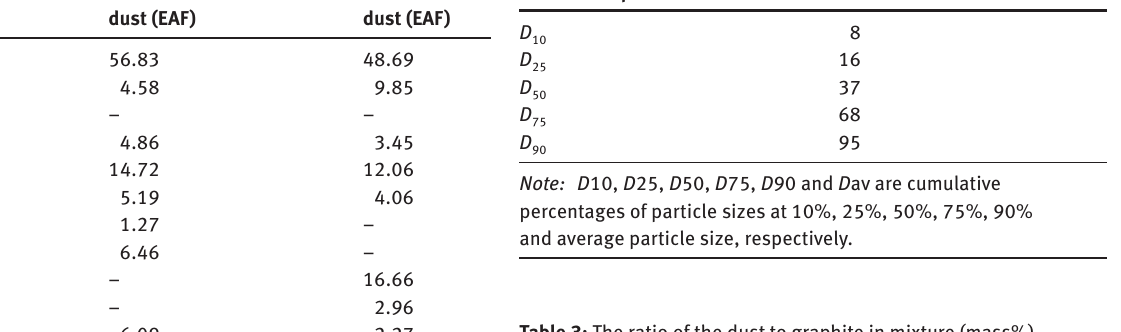
Table 2: Particle sizes of Zn-bearing stainless steelmaking dust (μm) Cumulative percent Particle size